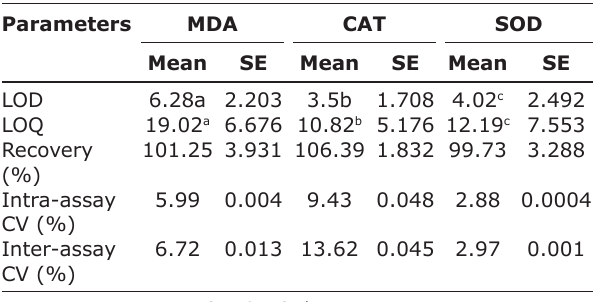
Figure-5: Standard calibration curves for malondialdehyde, superoxide dismutase, and catalase assays obtained by spectrophotometric analysis. (a) The calibration curve for Malondialdehyde (MDA) was obtained by measuring the absorbance of the pink adduct produced by the reaction of MDA with thiobarbituric acid at 100°C. The ABSR linearly corresponds with MDA concentration in sample. (b) Linearized rate of superoxide dismutase (SOD) was calculated from the quotient of blank with itself, standard and sample absorbance. Linearized rate increases with an increase in SOD activity. (c) An indirect peroxidase assay was used to quantify the concentration of formaldehyde released by CAT in the presence of H O 2 2 Table-4: Parameters for validating spectrophotometric assays of malondialdehyde, catalase, and superoxide dismutase.